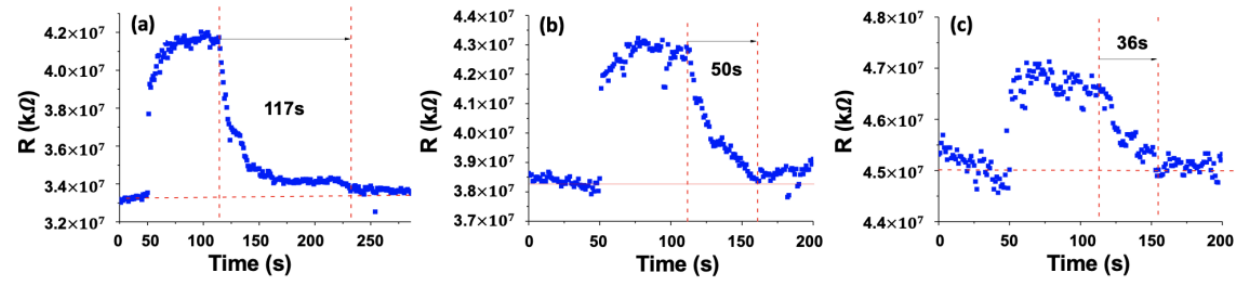
Figure 10. Exposure of gCN sensor device at 1000 ppm of CO 2 at ( a ) 30 °C, ( b ) 35 °C and ( c ) 40 °C. From the plots of Figure 10, the recovery time as a function of temperature indicates the shortest recovery time of ~36 s achieved at 40 ◦ C, while higher recovery times were registered at 30 ◦ C and 35 ◦ C, at ~117 s and ~50 s,